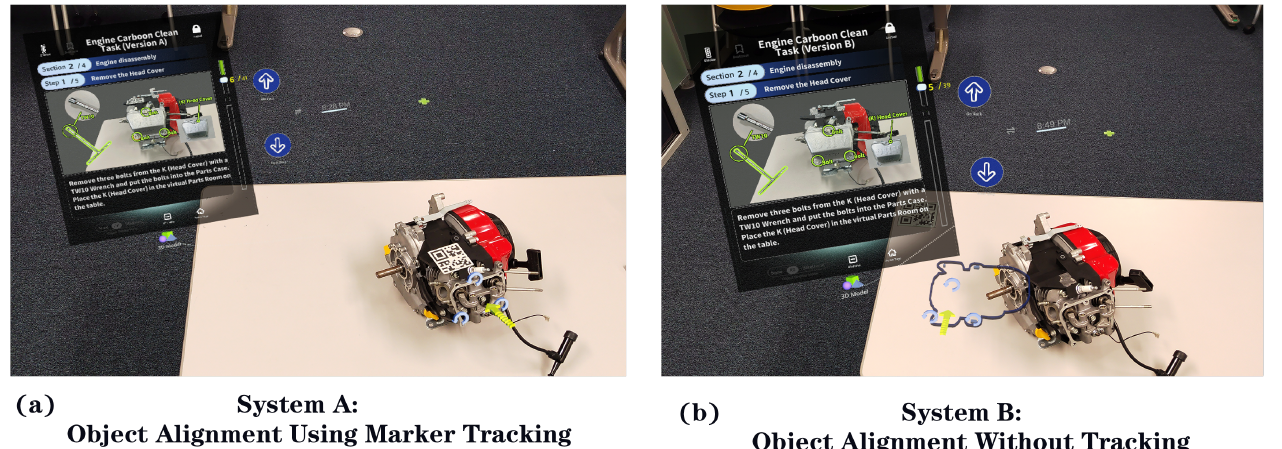
Figure 29. The difference between the two systems in the engine maintenance task. ( a ) System A can display the 3D model or sub-panels in the correct position/orientation by marker tracking. ( b ) In system B, if the object (the engine) is accidentally moved, the participants need to move the object back to its original position, relying on the wire-frame of the virtual engine bottom